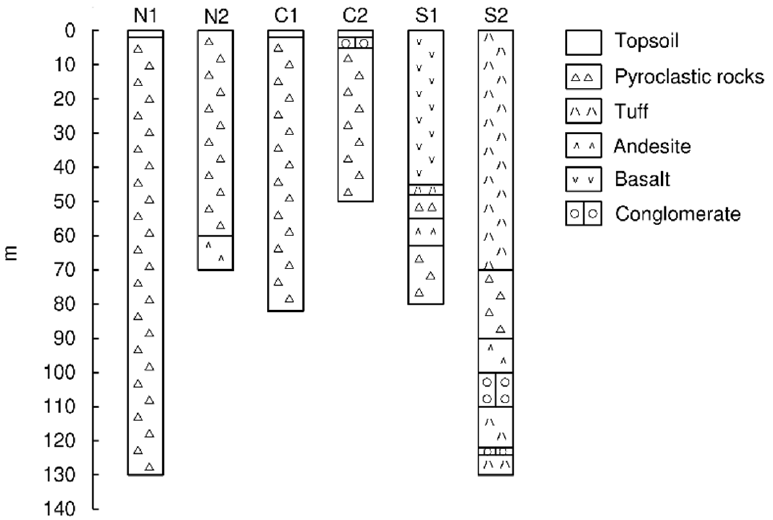
Figure 3. Geologic strata of the three regions. The data were reported by Murakami [3].